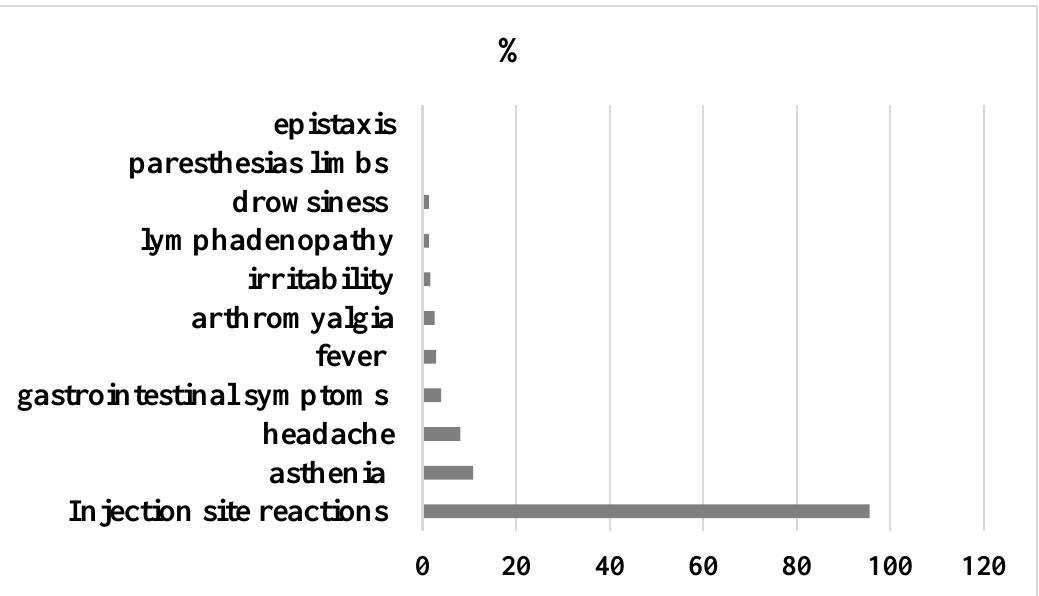
Figure 1. Adverse Events 24 – 48 h after first dose.